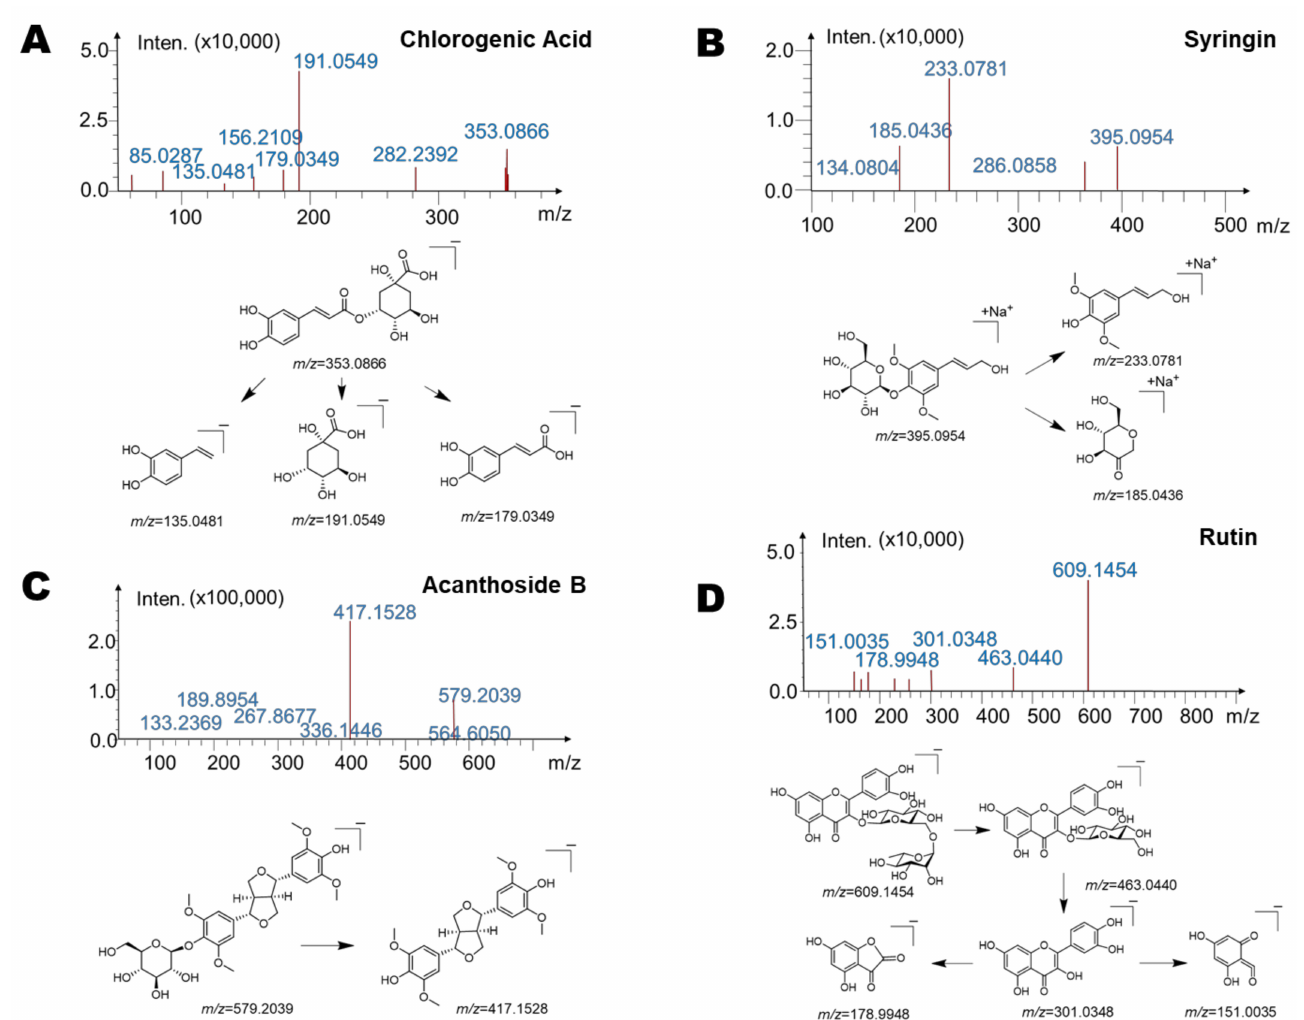
Figure 2. High-resolution mass spectrometry of the four main substances (chlorogenic acid, syringin, acanthoside B, rutin) of Saussurea involucrata . ( A ) The mass spectrometric cleavage pathway of chloro- genic acid. ( B ) The mass spectrometric cleavage pathway of syringin. ( C ) The mass spectrometric cleavage pathway of acanthoside B. ( D ) The mass spectrometric cleavage pathway of